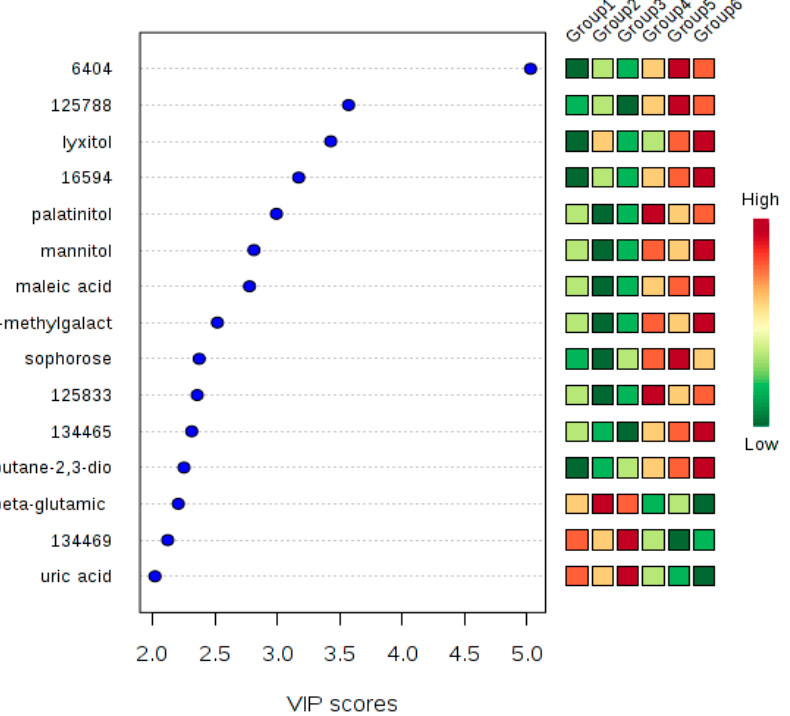
Figure 2. Potential metabolomic markers differentiating ‘Niaouli’ (genotypes groups 1–3) from ‘Kouilou’ (groups 4–5) and ‘Java’ (group 6). The variable importance in projection (VIP) scores on the x-axis provide an estimate of the contribution of a given predictor (metabolites shown on the y-axis) to the Partial Least Square (PLS) regression above 2. The higher the VIP score, the better the metabolite is as a predictor of the discrimination among genotypes.